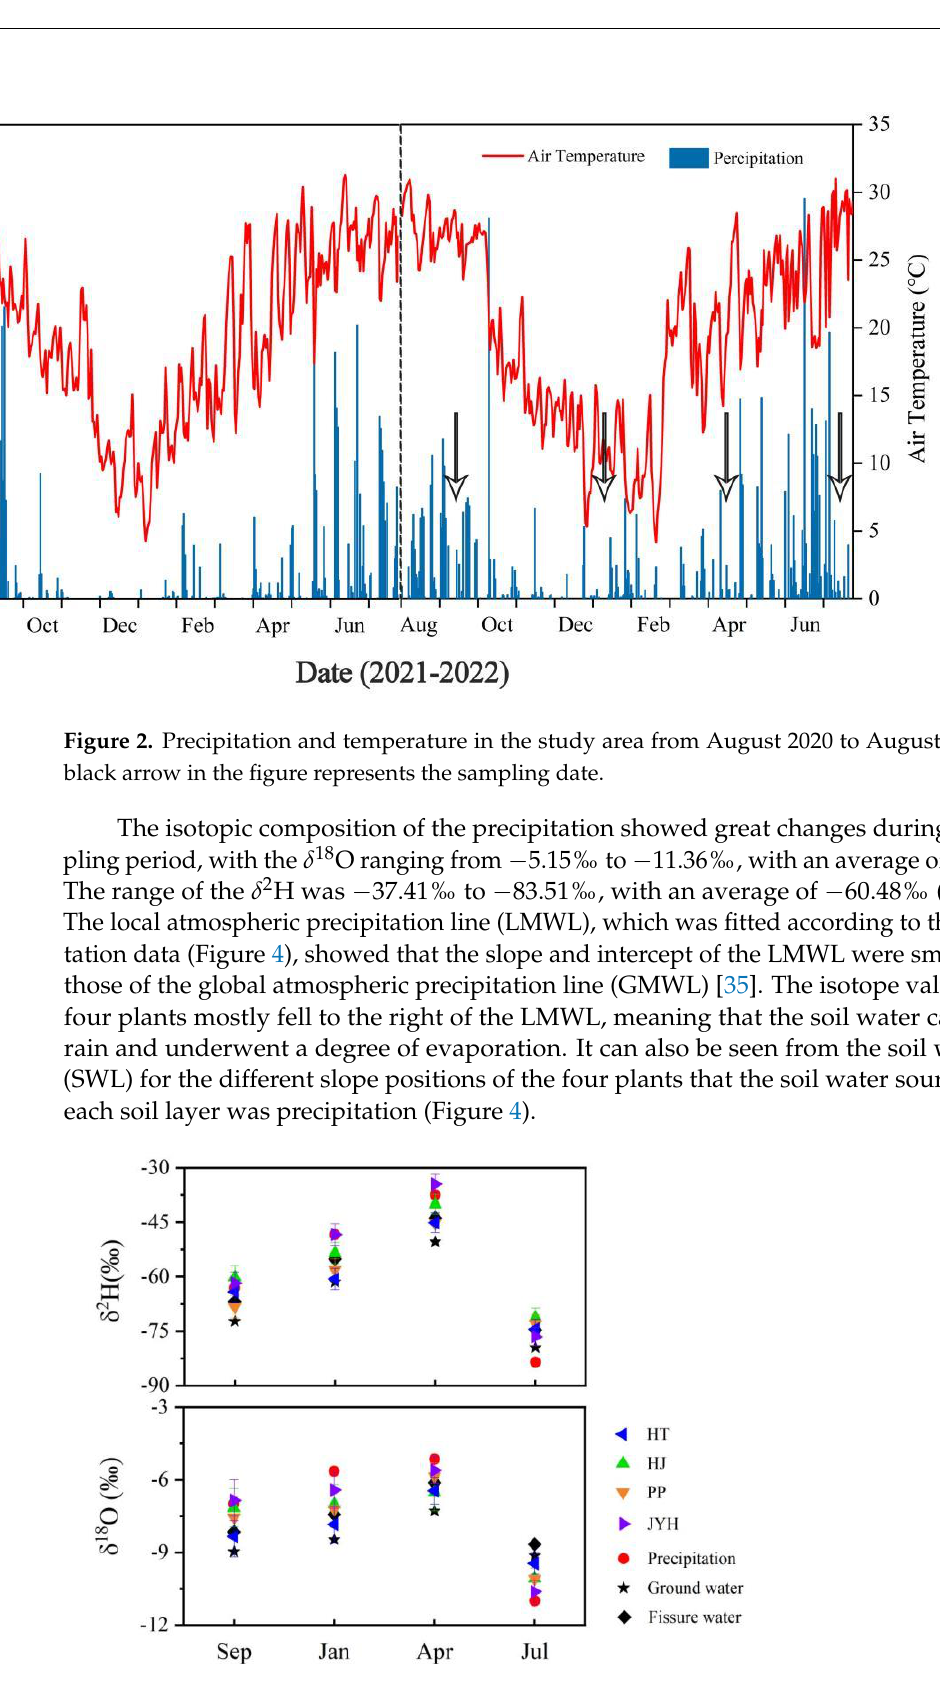
Figure 4. The linear regression relationship between δ 2 H and δ 18 O of soil moisture of four plant species in the study area. SWL represents soil water line based on isotopic data of soil water. LMWL represents the local meteoric water line (y = 7.86x + 9.02, R 2 = 0.98, and p < 0.01). GMWL is the global meteoric water line (y = 8x + 10) [35]. LMWL and GMWL are plotted in each panel for reference. The isotopic compositions of xylem water from four species are shown in the Figure 4.